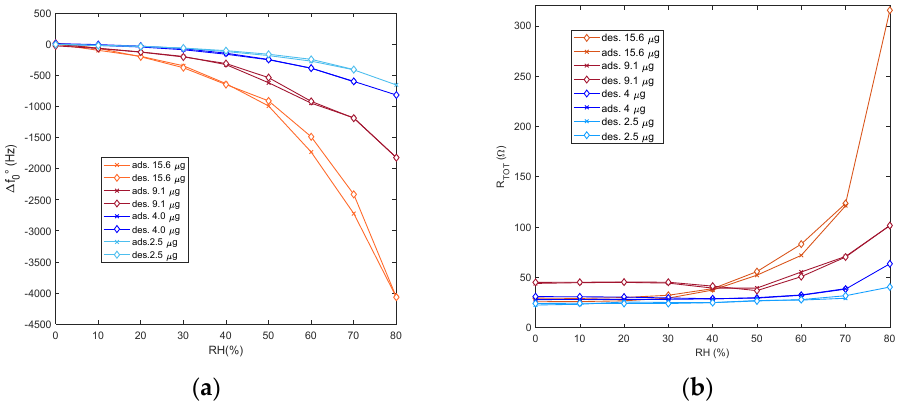
Figure 5. Measured responses of the functionalized QCMs as a function of the RH value. The tested QCMs are identified in the legend on the basis of the SWCNT deposited mass; ( a )—frequency shift of the oscillator frequency with respect to frequency measured in dry air; ( b )—motional resistance as measured by the adopted oscillator